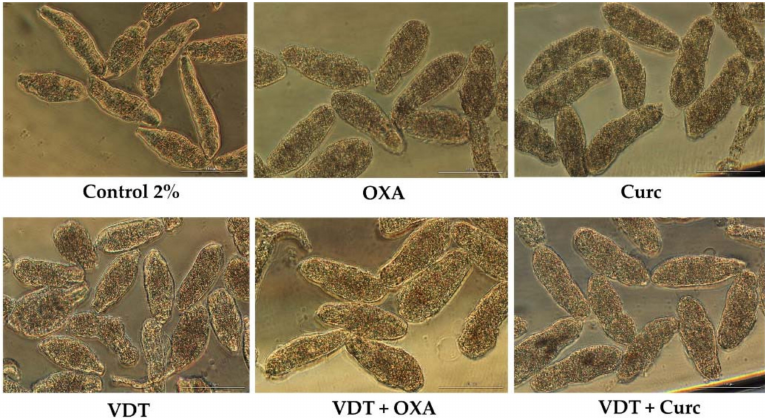
Figure 6. Representative micrographs of NTS incubated with combinations of VDT, Flav, and Resv alone and in combination at 25 µ M and 1:1 constant ratio at 72 h post exposure. Scale bar: 100 µ